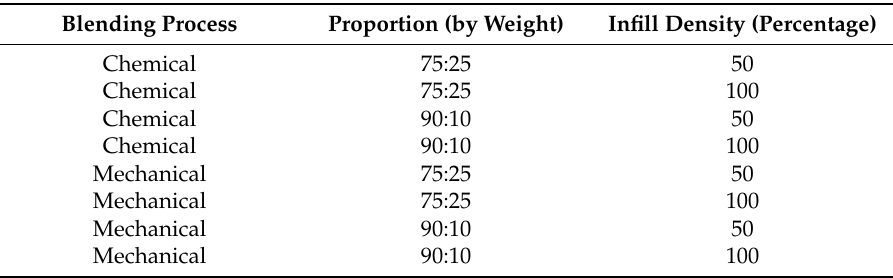
Table 3. Control log of experiment.